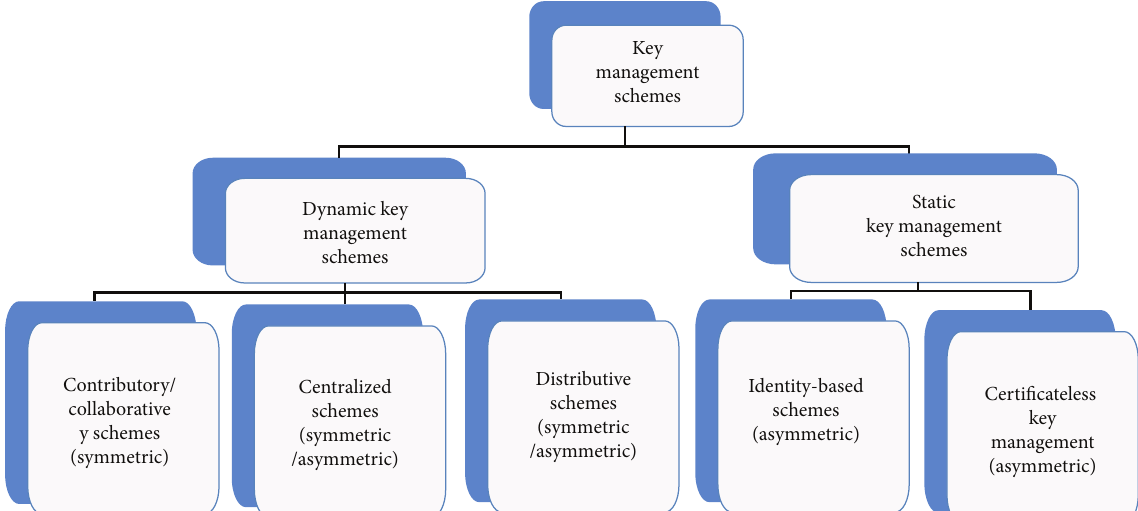
Figure 2: Classification of key